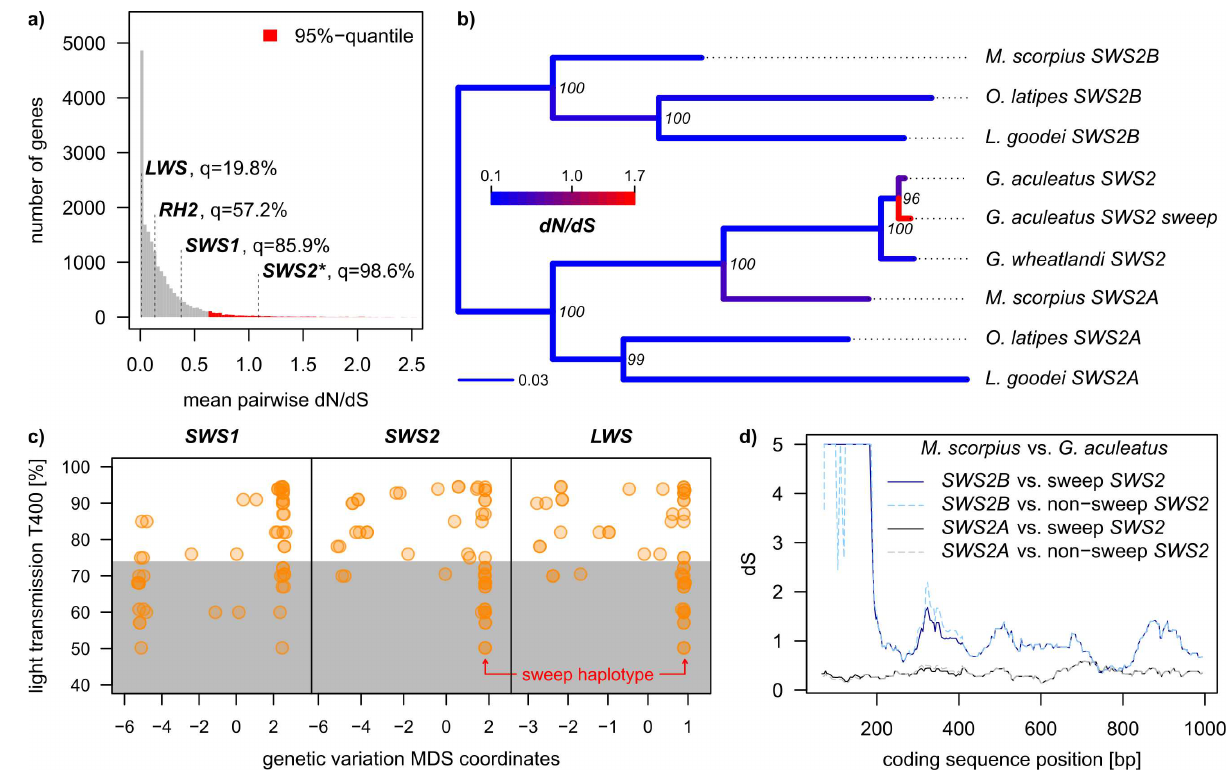
Fig 6. Acceleratedprotein evolution, evolutionary origin of threespine stickleback SWS2 , and association with blackwater habitation. (a) SWS2 shows an unexpectedhigh frequency of amino acid polymorphisms given the total numberof mutationsin SWS2 .The distributionof meanpairwiserelativeproteinsequencedivergence (mean ratioof non-synonymousto synonymous substitutions[dN/dS]) is basedon 17,846functionalproteincodinggenesin the stickleback genome.Eachvalueis basedon pairwisecomparisons betweenall 56 haplotypesin the “adaptiveradiationdataset” containingone individualper population from the HaidaGwaiiadaptiveradiation,two mainland freshwater,and a marinesite (see materialsand methods).(b) Rootedphylogenetic tree of SWS2 opsinsin sticklebackand relatedtaxa, whichhaveretainedtwo ancient SWS2 paralogs. Both red-shifted (“sweep”)and blue-shifted threespinestickleback haplotypesare derived from the ancestral SWS2A paralog,and the haplotypeunderselection has rapidlyaccumulated amino acidchanges(dN/dS = 1.64). Branches are colorcodedwith maximum-likelihood dN/dS estimates, and nodelabelsshow Bayesianbranchcredibility.(c) Genetic variationat SWS2 , LWS , and SWS1 ,each summarized in singlemultidimensionalscaling(MDS) coordinates, is associated with lighttransmissionat 400nm (T400), but only variationat the sweephaplotypecarryingcodingand noncoding SWS2 and noncoding LWS variationis associatedwith the colonization of blackwaterhabitats.The grey area indicatesblackwaterlakes, following[16].(d) Gene conversiondid not contributeto molecularconvergence betweensticklebackhaplotypesand SWS2 paralogsin other fish: synonymous divergence(dS) betweenthe two threespinestickleback haplotypesis largerto the SWS2B paralogthan to the SWS2A paralog,exceptfor a regionaroundbp 700–800,a regionwithoutintraspecific aminoacid variation.MeanpairwisedN/dS valuesfor all genesshownin (a), MDS valuesfor the threeopsins SWS1 , SWS2 ,and LWS in (c), and dS valuesin (d) can be foundin S1 Data.